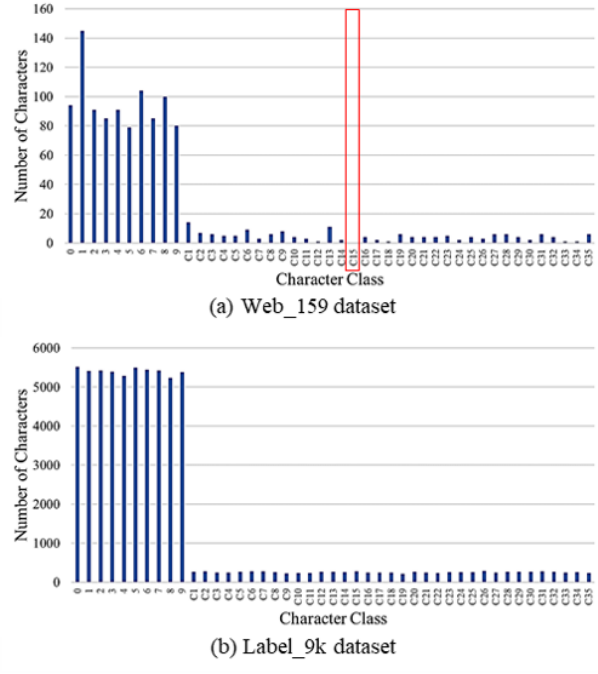
Figure 3. Character class distribution of Web_159 and Label_9k